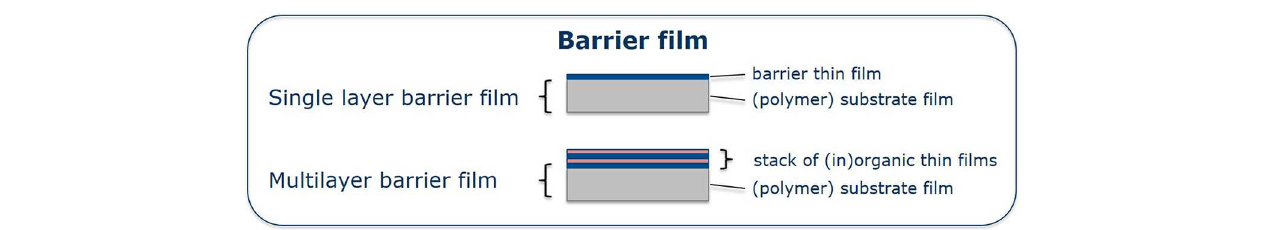
FIGURE 2 | Notation of barrier films as used in this review.